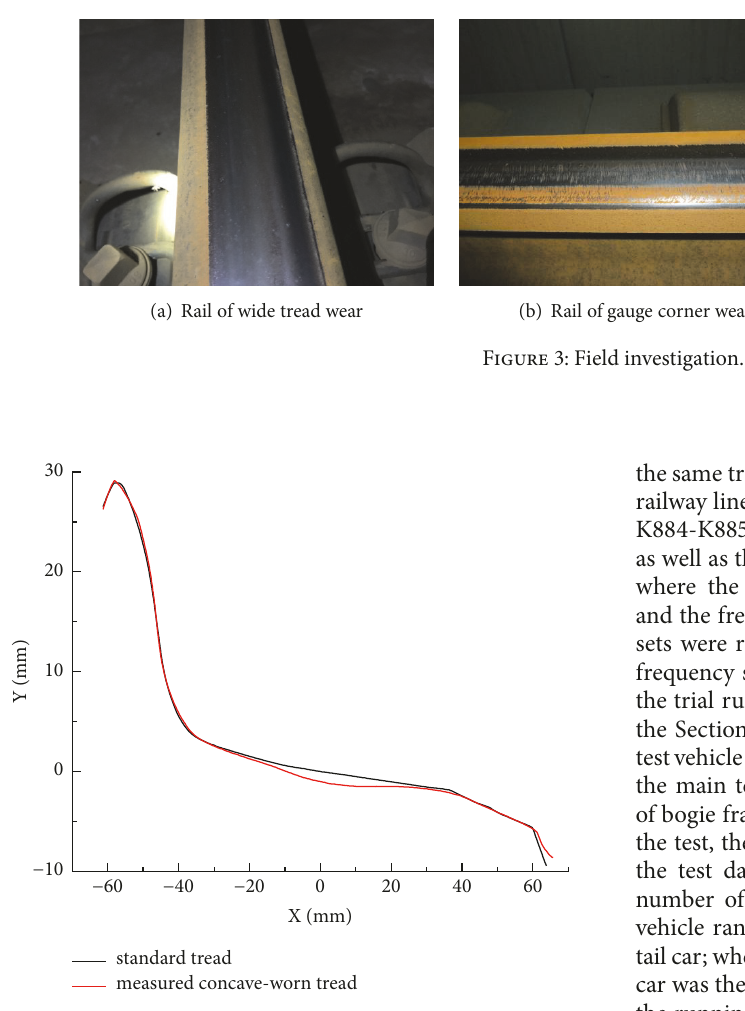
Figure 4: The measured concave-worn tread